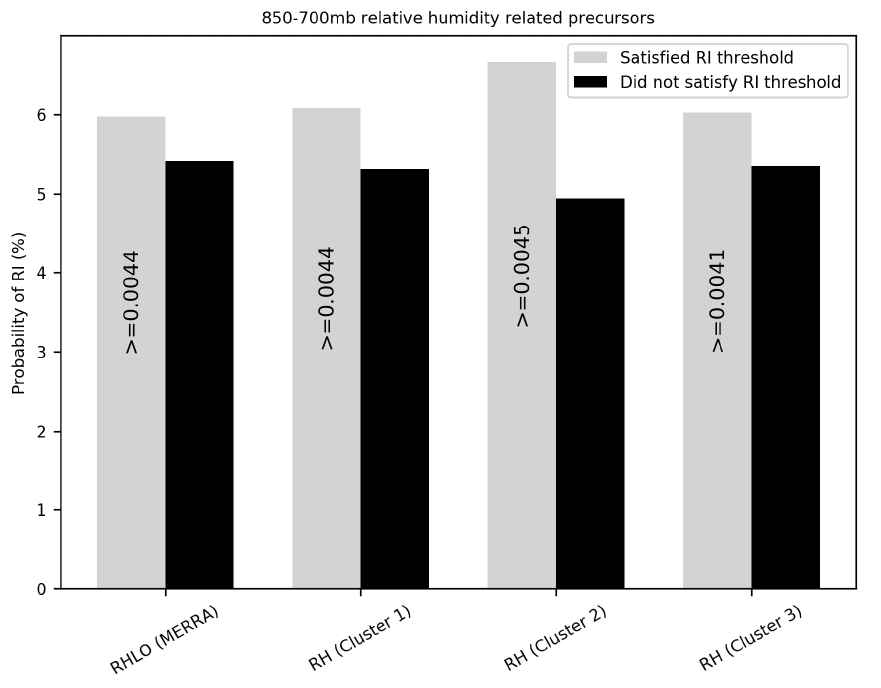
Figure 9. The probability of RI when the 850–700 hPa relative humidity related precursors were satisfied for the RI and non-RI samples. The RI thresholds for each of the predictors are also presented in kg/kg.